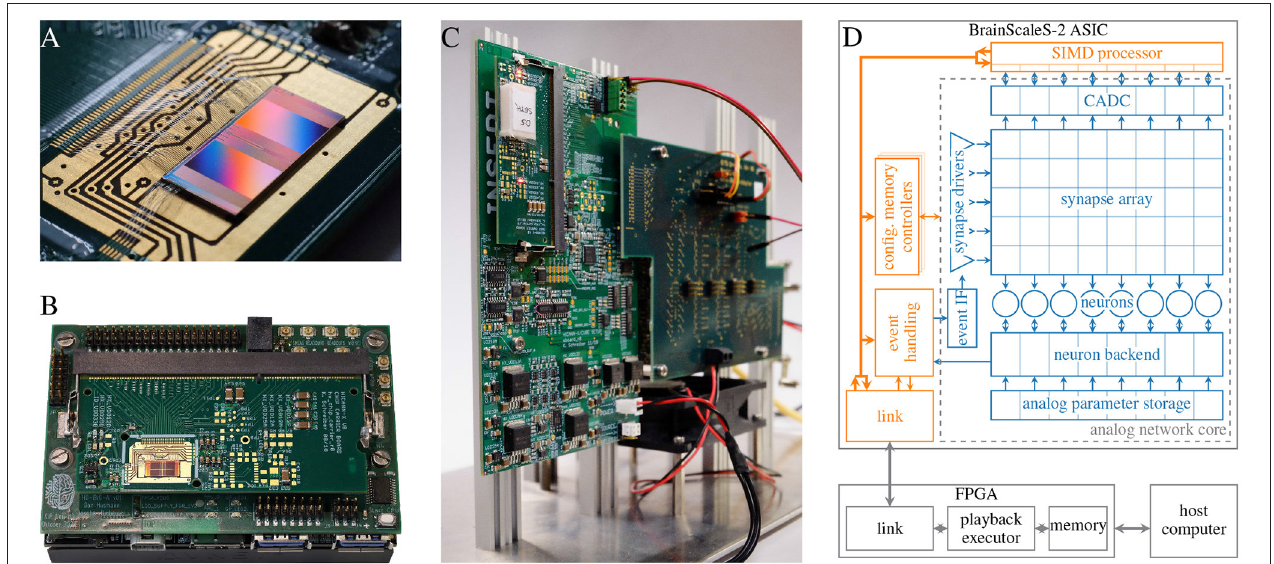
FIGURE 1 | Overview of the BSS-2 system. (A) BSS-2 ASIC bonded to a carrier board. The ASIC is organized in two hemispheres each hosting 256 neurons and the accompanying synapse matrix (cf. D ). (B) Portable BSS-2 system. (C) Laboratory setup. (D) Overview over the signal flow in the BSS-2 system. The depicted analog neural network core and SIMD processor represent one of the two hemispheres visible in (A) , which are mirrored vertically below the